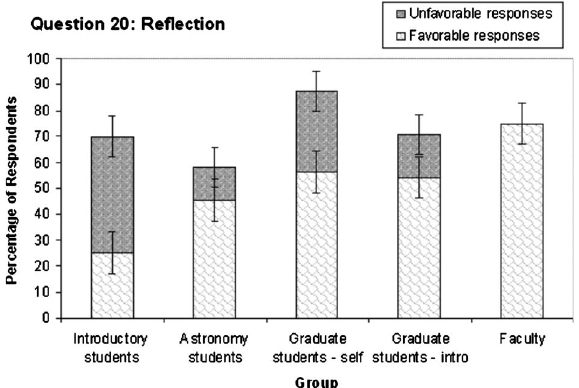
FIG. 11. Histogram showing favorable (cid:1) agree (cid:2) and unfavorable (cid:1) disagree (cid:2) responses for survey question (cid:1) 20 (cid:2) . The histogram shows that none of the groups had 80% individuals who agreed that they take the time to reflect and learn from the problem solutions after solving problems but the reasons for the lack of reflection varied across different